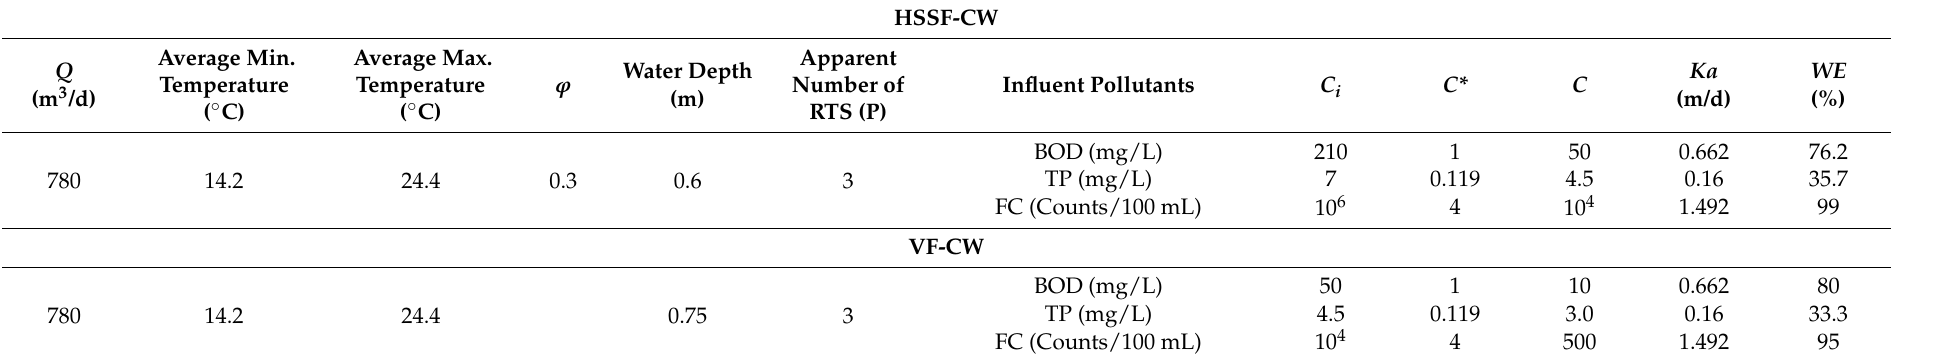
Table 2. Model input data for the proposed wastewater treatment system as VF-CW after the HSSF-CW.